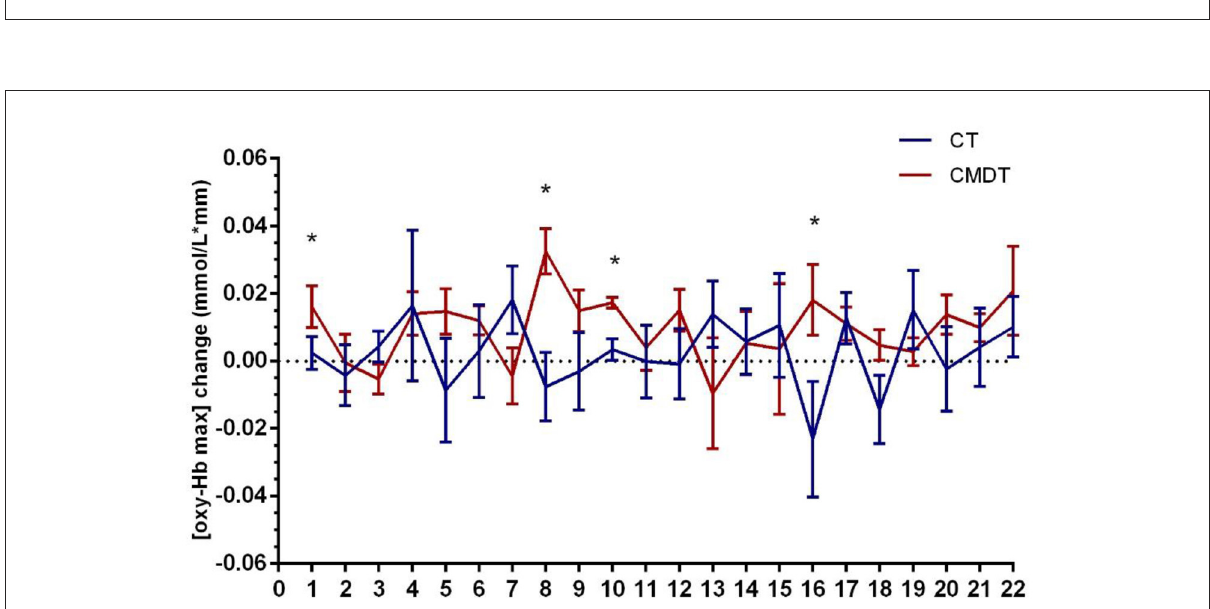
FIGURE5 Changes in [oxy-Hb max] across 22 channels. Error bars represent one standard error of the mean. *Statistical